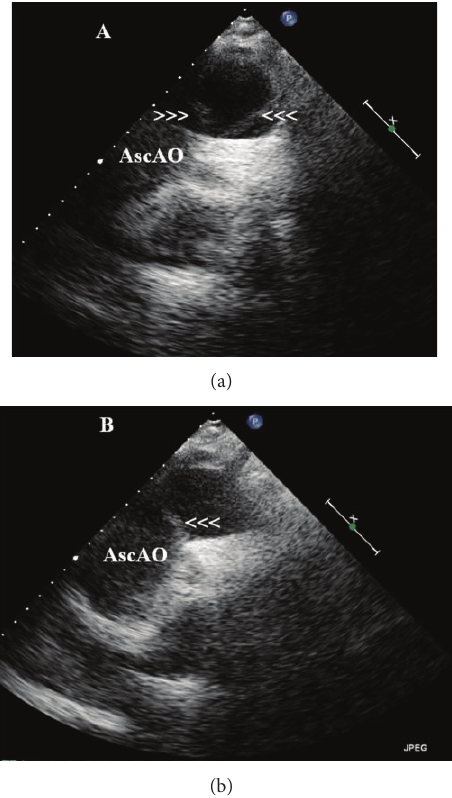
Figure 3: Transthoracic echocardiogram in suprasternal view showing dissection flap in ascending aorta extending up to arch dividing the aorta into a large false lumen and a small true lumen (arrowheads) in a patient with ascending aortic dissection. AscAo: ascending